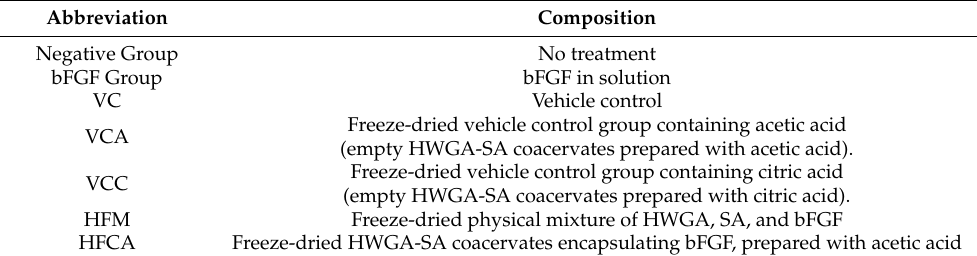
Table 1. Sample name abbreviations and their